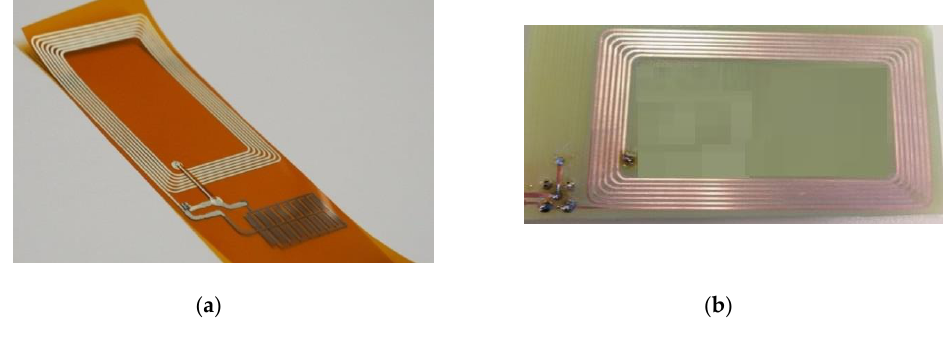
Figure 3. Module the reader and coupling between reader and wireless sensor at resonance condition.